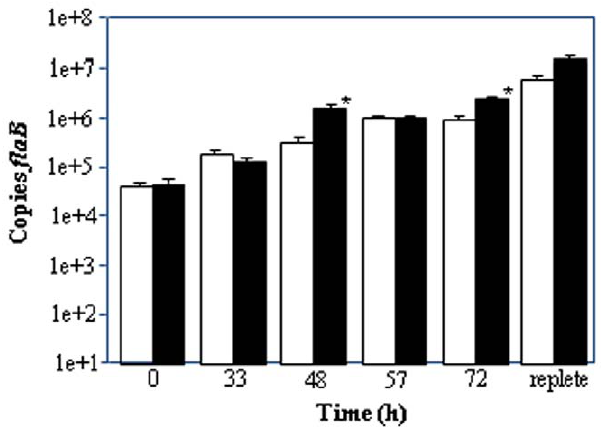
Figure 2. qPCR-based enumeration of B.burgdorferi in individ- ual actively feeding nymphal ticks. WT- (white bars) or bba64 mutant- (black bars) infected nymphs were fed on mice and removed at 33 h, 48 h, 57 h, and 72 h. Flat (0 h) and replete infected nymphs were also collected. Borrelia were enumerated by qPCR using flaB Taqman probe and primers. The data represents the average of 5 individually crushed nymphs per time point and error bars correspond to the SEM. Statistically significant differences (*) existed between WT and bba64 mutant samples (P # 0.001) using Mann-Whitney rank sum test.